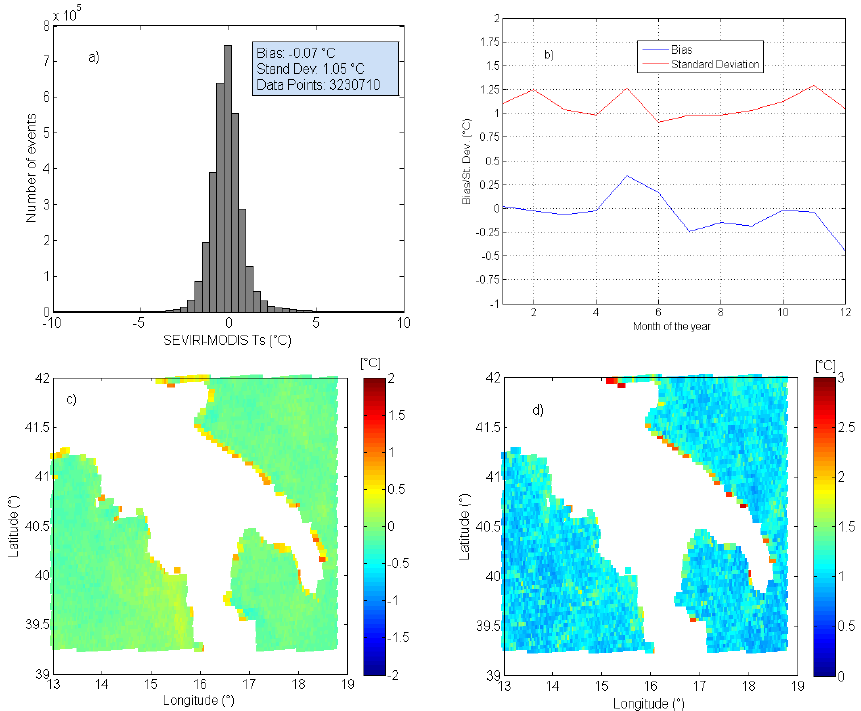
Figure 15. Year 2013. Comparison of SEVIRI-retrieved skin temperature with MODIS: (a) histogram of the surface temperature difference (cid:49)T s (SEVIRI–MODIS), (b) monthly mean and related SD of (cid:49)T s , (c) map of the yearly average surface temperature difference (SEVIRI– MODIS) and related SD (d) .